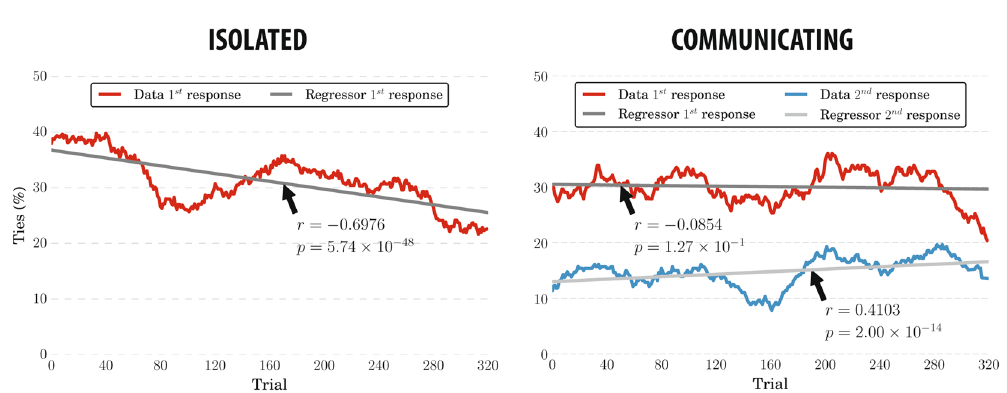
Figure 3. Mean error rates across participants for Experiments 1b (left) and 2 (right) computed using a simple moving average considering 40 consecutive trials. The blue line (right) shows the mean error rates achieved by considering the second response of participants. The grey lines show the linear regressors fit to the data. Their correlation coefficients and two-sided p -values are also reported.